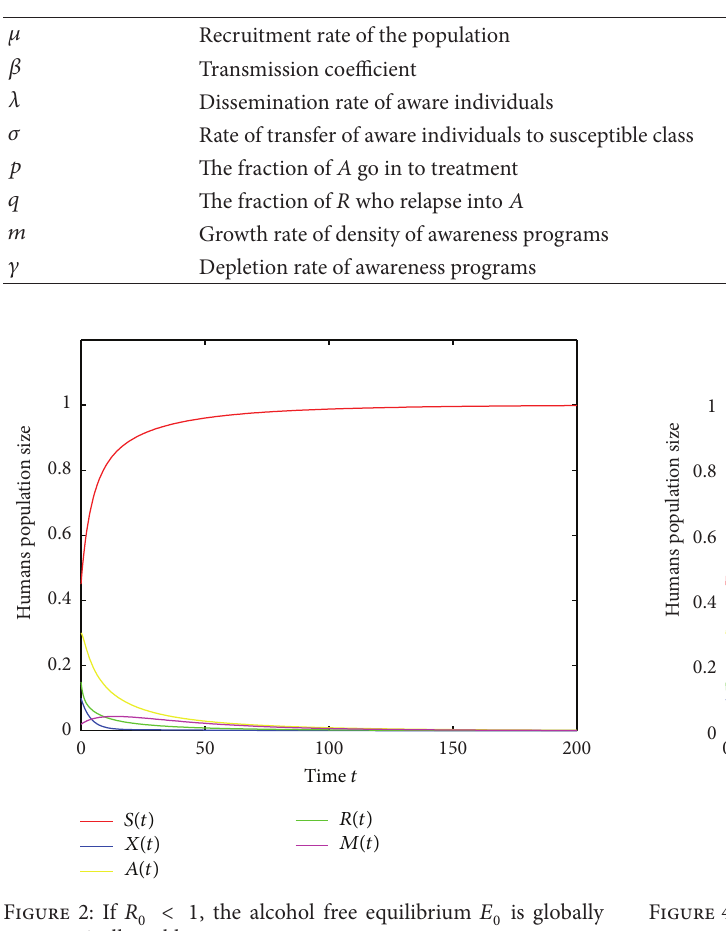
Table 1: Description and estimation of parameters.